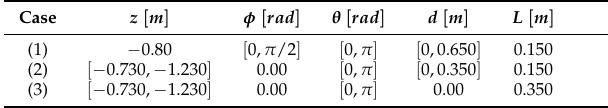
Table 3. Description of the three considered